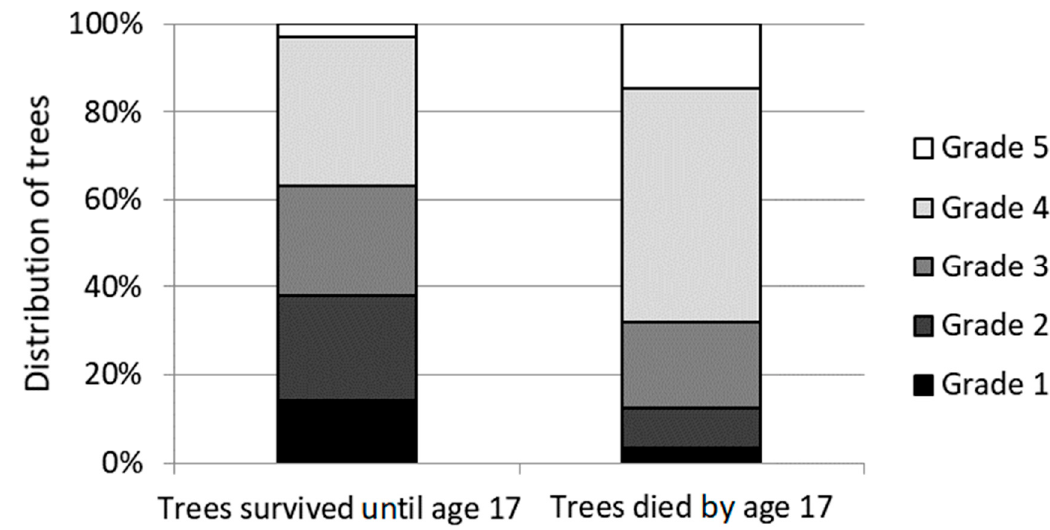
Figure 1. Tree distribution among the needle cast damage grades (1–5) for trees that survived until the age of 17 years and trees that died at the age of 6 to 17 years.